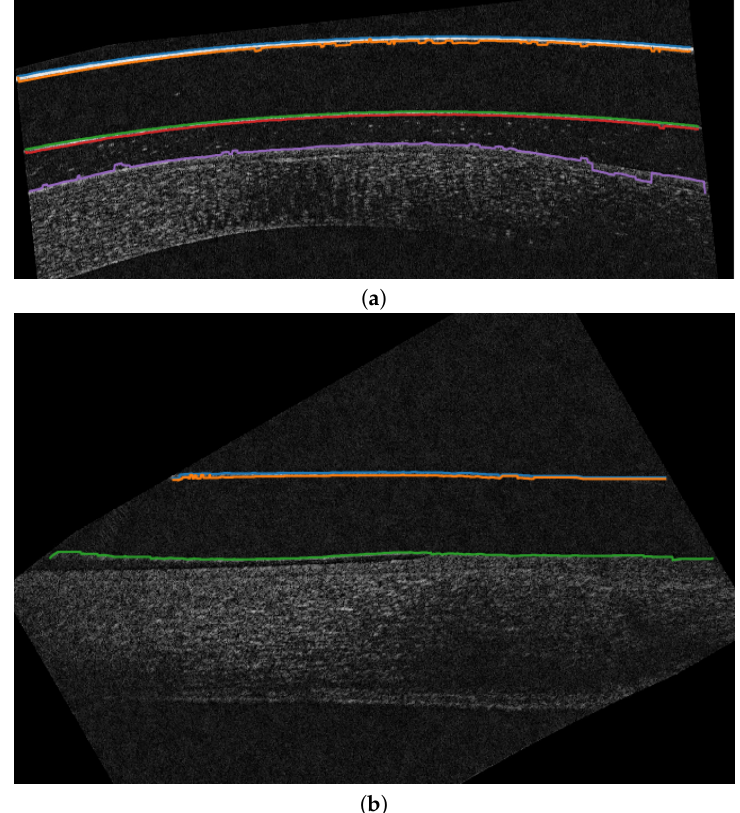
Figure 7. Example of localization of the areas of interest. ( a ) AS-OCT image of the central region with the outer and the inner layers of the scleral contact lens (SCL) and the cornea localized. ( b ) AS-OCT image of the lateral region with the outer layer and the cornea